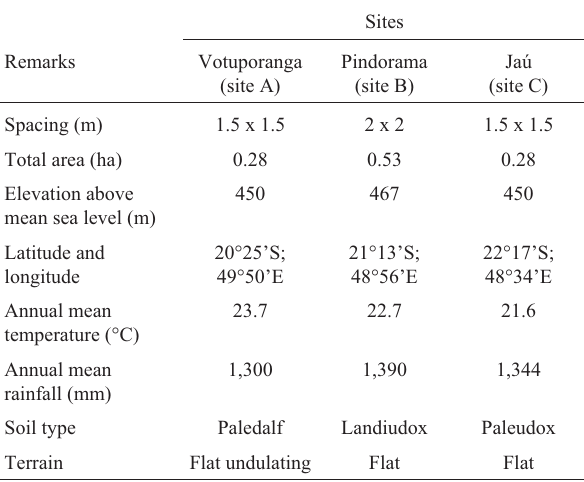
Table 1 - Planting of 22 open-pollinated Hevea progenies at three sites in the Brazilian state of São Paulo. The Hevea seedlings were planted at all sites in 1994 using a randomized block design, a planting density of 1 row x 10 plants (10 plants/plot) and six